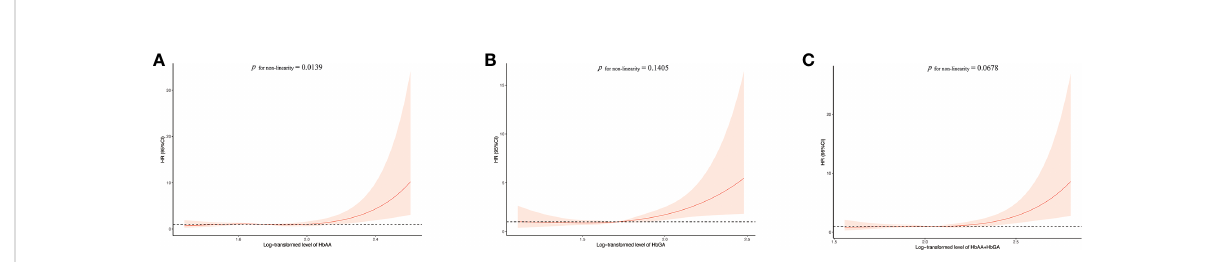
FIGURE 1 Association between HbAA (A) , HbGA (B) and HbAA+HbGA (C) with cancer mortality in total population. HRs were adjusted for age, sex (male/ female), race (Mexican American, other Hispanic, non-Hispanic white, non-Hispanic black or other races), regular exercise (yes/no), body mass index (BMI), education (< 9th Grade, 9-11th Grade, High School Grade, GED or Equivalent, Some College or AA degree, College Graduate or above), income (< $20,000, $20,000-$45,000, $45,000-$75,000, $75,000-$100,000 or > $100,000), current smoker (yes/no), current drinker (yes/no), energy (kcal/d), cotinine (ng/ml), diabetes (yes/no), hypertension (yes/no), dyslipidemia (yes/no) and INFLA-score. HR, hazard